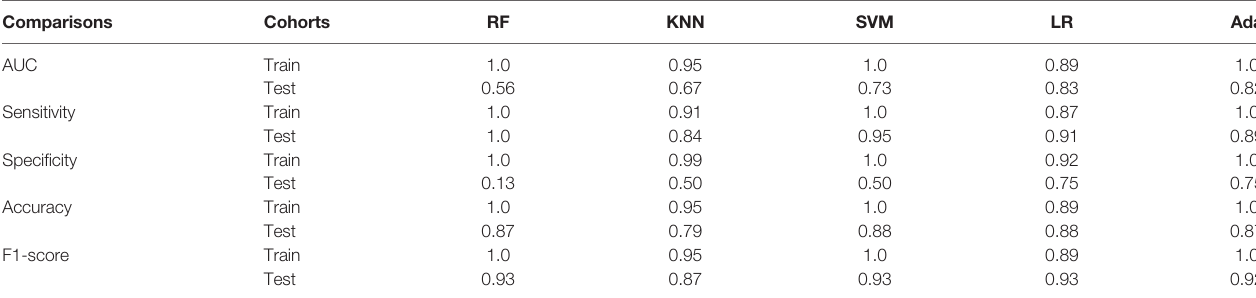
TABLE 3 | The performances of fi ve prediction